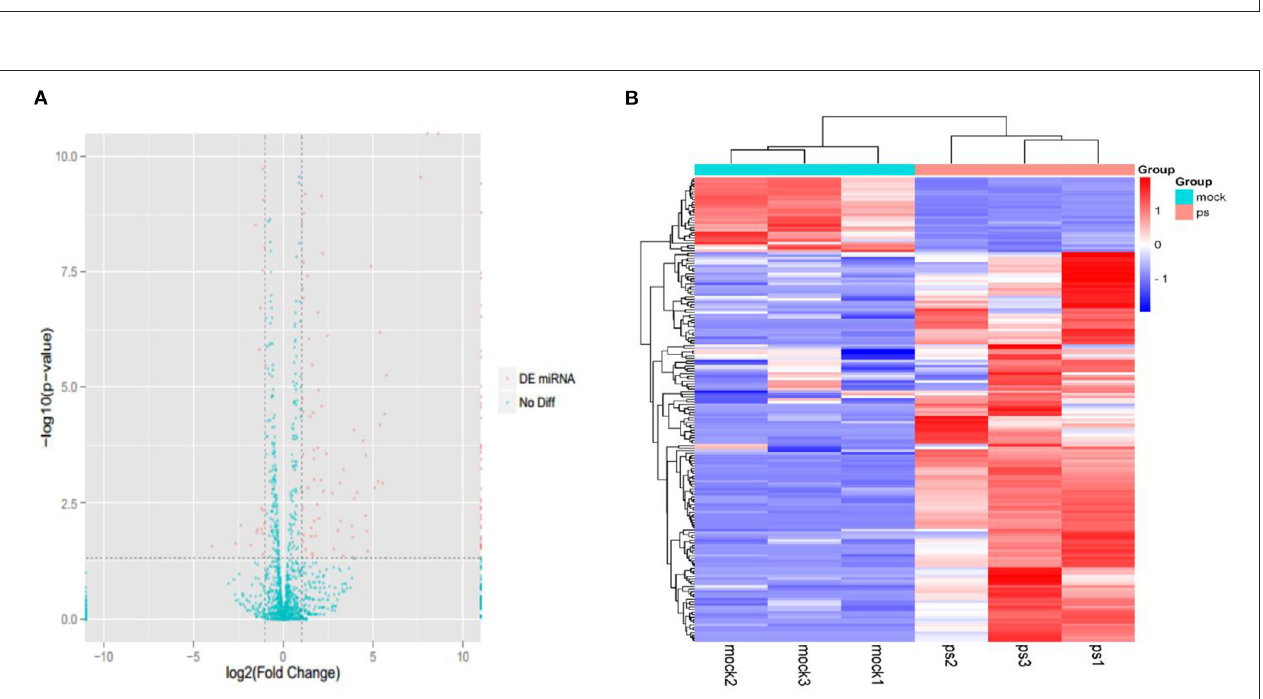
FIGURE 2 | The expression profiling of miRNAs in the CDV-infected and control groups. (A) The volcano plot displaying the distribution of differentially expressed miRNAs in infected groups compared with the uninfected group. Red dots indicate significantly different miRNA and green dot is no significantly different miRNAs. (B) Heat map showing the hierarchical clustering of miRNAs that are common to the six samples. Red and purple indicate higher and lower expression in Mv. l. Lu cells, respectively. The color scale was the normalized count.